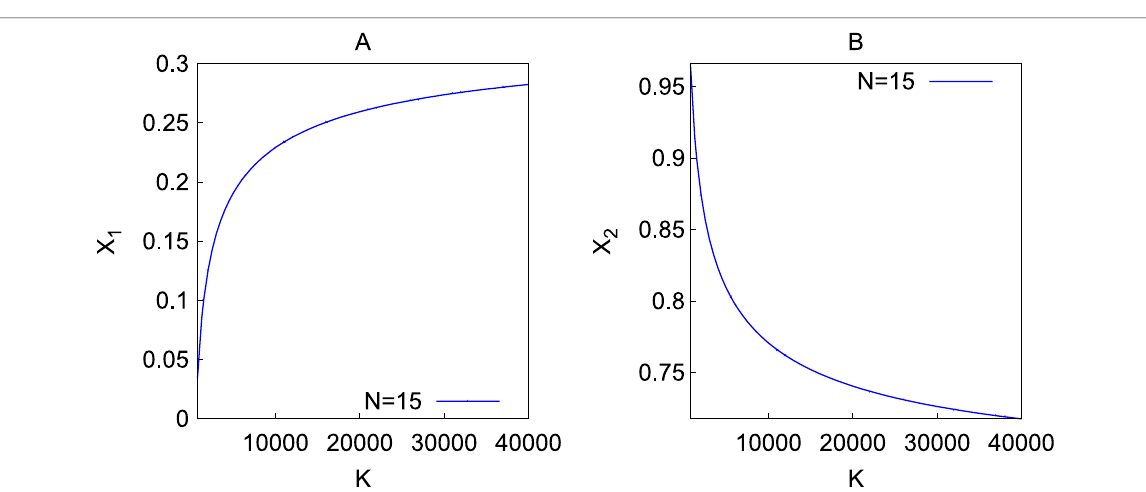
Fig. 15 Case (5) Parametric Study for Exact Solution and RRM. A Variation of x 1 with the soil stiffness (K). B Variation of x 2 with the soil stiffness